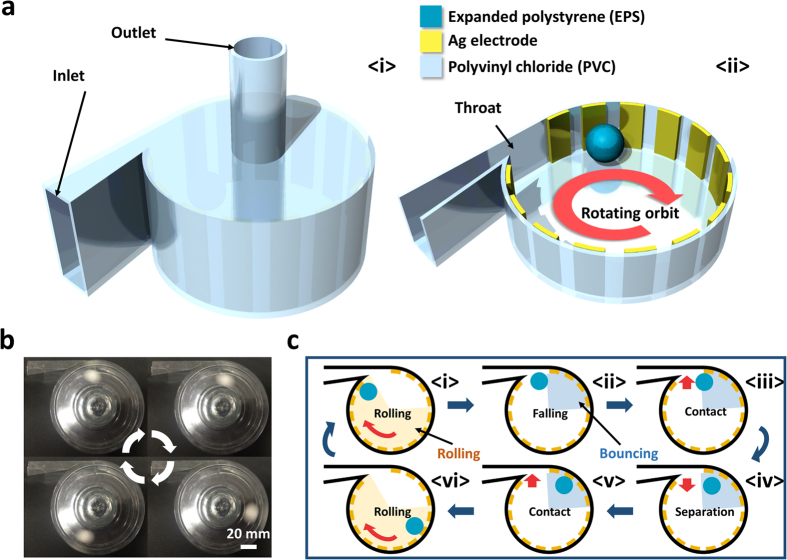
The wind rolling triboelectric nanogenerator.(a) The schematic illustration of the inner structure of the WR-TENG. (b) Photograph of the EPS sphere rotating inside the WR-TENG (air flow velocity of 2.2 m/s). (c) The working mechanism of a WR-TENG.